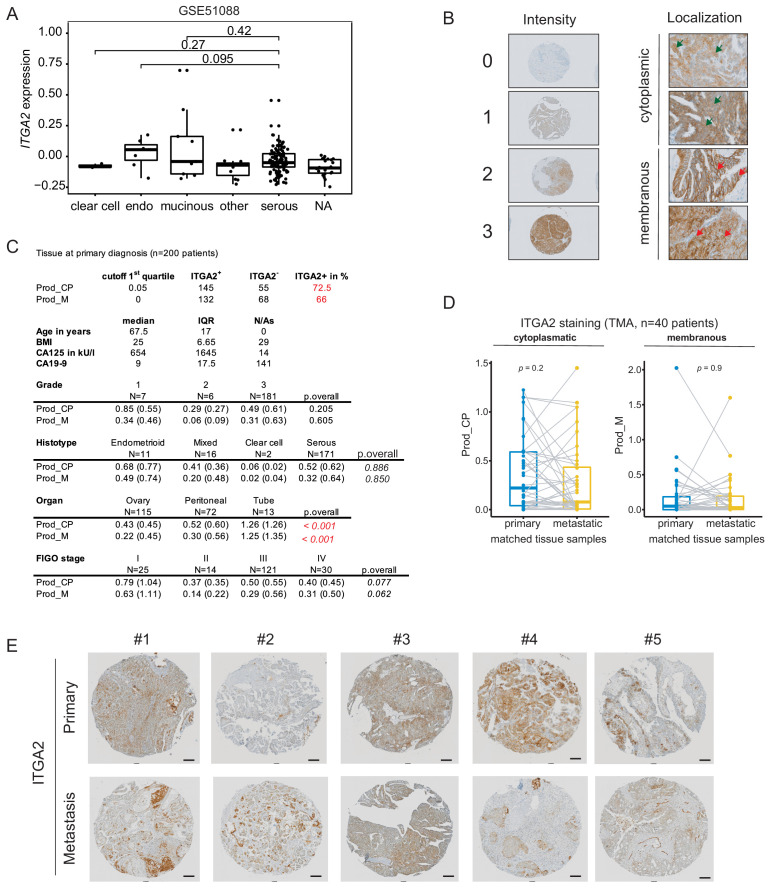
Heterogeneous ITGA2 expression in matched primary and metastatic tumor independent of tumor origin and histotypes.(A) ITGA2 expression among ovarian cancer histotypes from GSE51088 RNA-seq dataset (n = 172). (B) Representative IHC images show the intensity and localization of ITGA2 expression. Green and red arrows point out the positive cytoplasmic and membranous staining, respectively. (C) Summary of the product expression of ITGA2 in the tissue microarray according to grade, histotype, organ, and FIGO stage. (D) Weighted average scores of ITGA2 expression in matched primary and metastatic tissue samples (n = 40). (E) Representative images of IHC staining for ITGA2 protein in five matched primary and metastatic tumors of patients with epithelial ovarian cancer . Scale bar 0.2 mm.